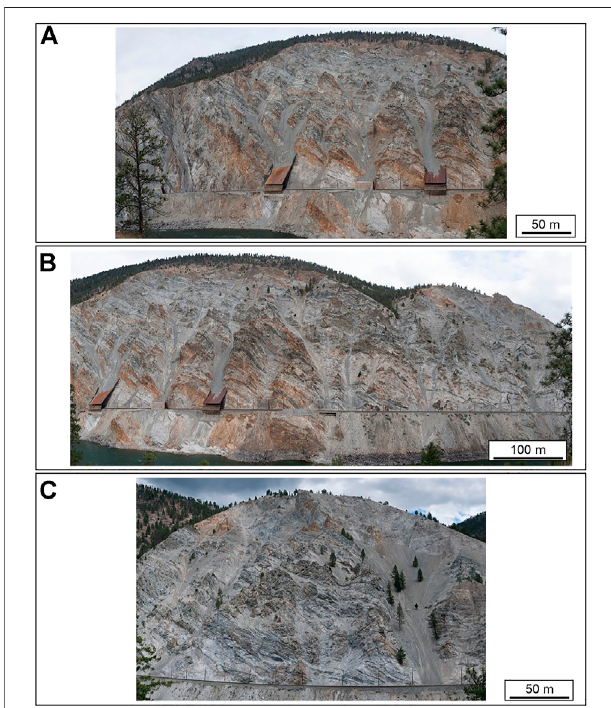
FIGURE 3 | Panoramic photographs of WCE. Note that the scale is not consistent throughout the images. (A) This photo shows the rock sheds and the portaltoWCWintheleft sideoftheimage. (B) Centralportion ofWCE. (C) Eastern most portion of WCE highlighting WCE channel 9.